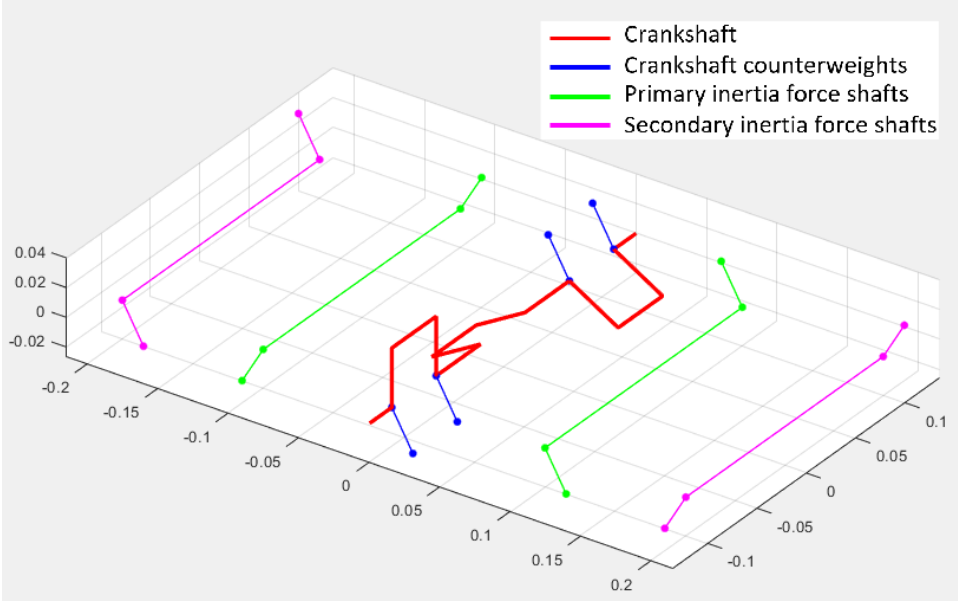
Figure 11. Geometry of crankshaft and balancing shafts for a 3 cylinder in-line engine.